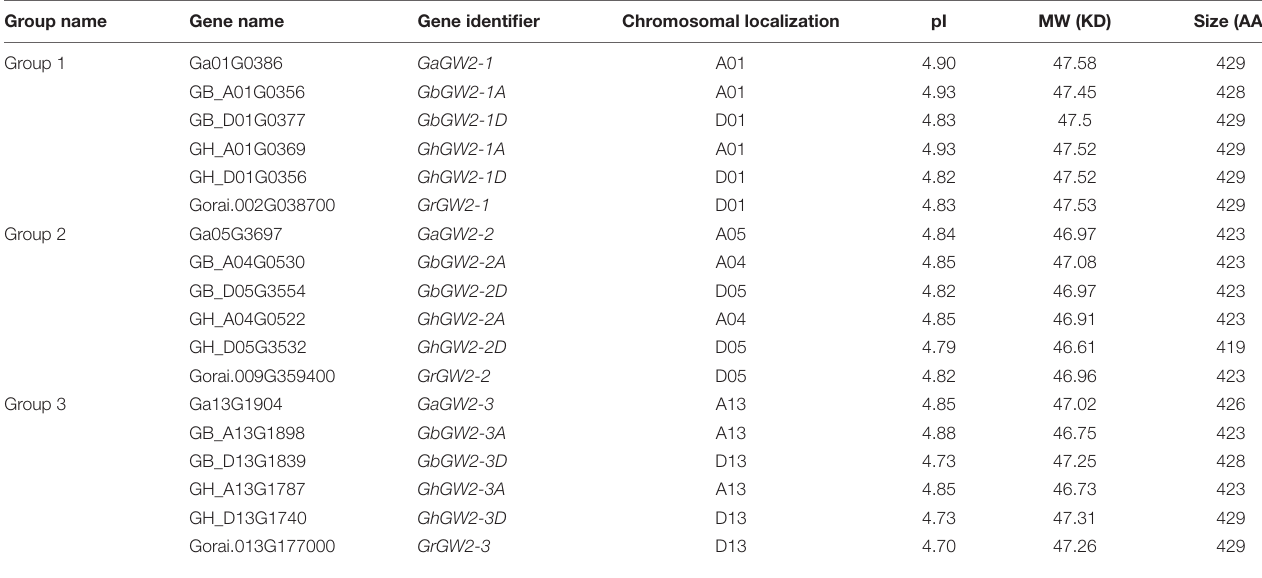
TABLE 1 | Information of the GW2- like genes in Gossypium